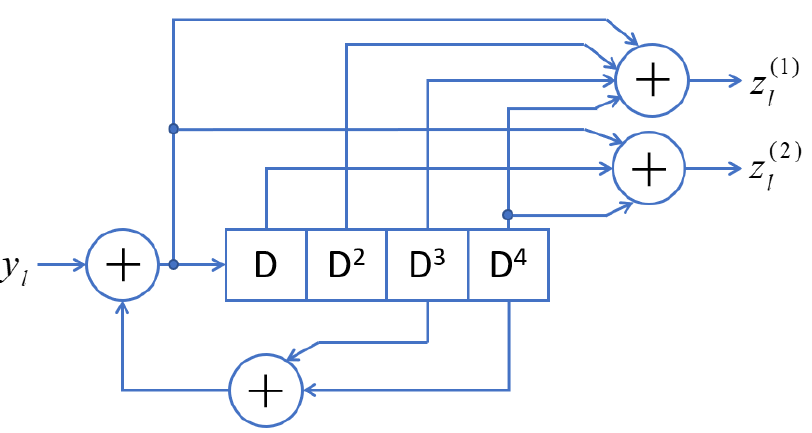
Figure 4. Block diagram of 1/2 Rate Spectral Line-Free Convolutional Encoder with feedforward and feedback polynomials (27,31) 8 and (23) 8 , respectively.